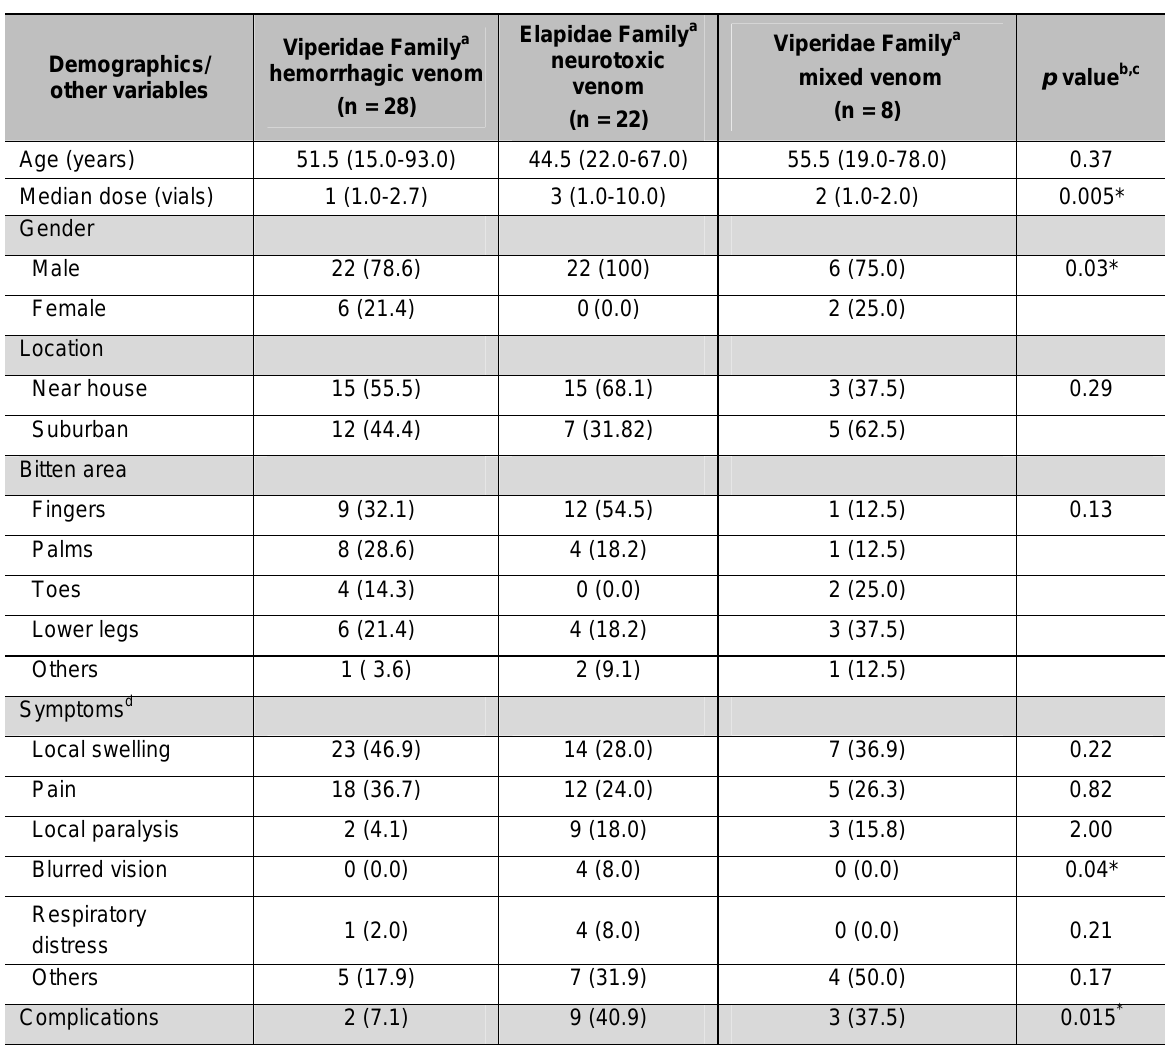
Table 1. Epidemiological characteristics of 58 patients bitten by venomous snakes who received antivenom treatment in the medical center of Taiwan, from